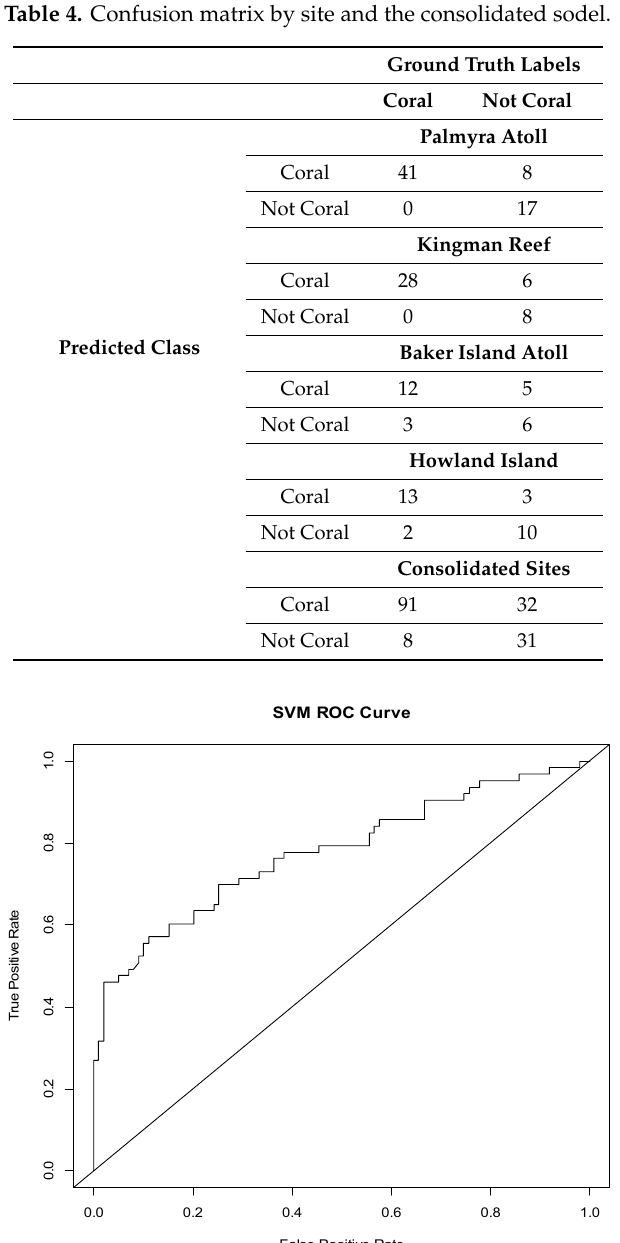
Table 4. Confusion matrix by site and the consolidated sodel.